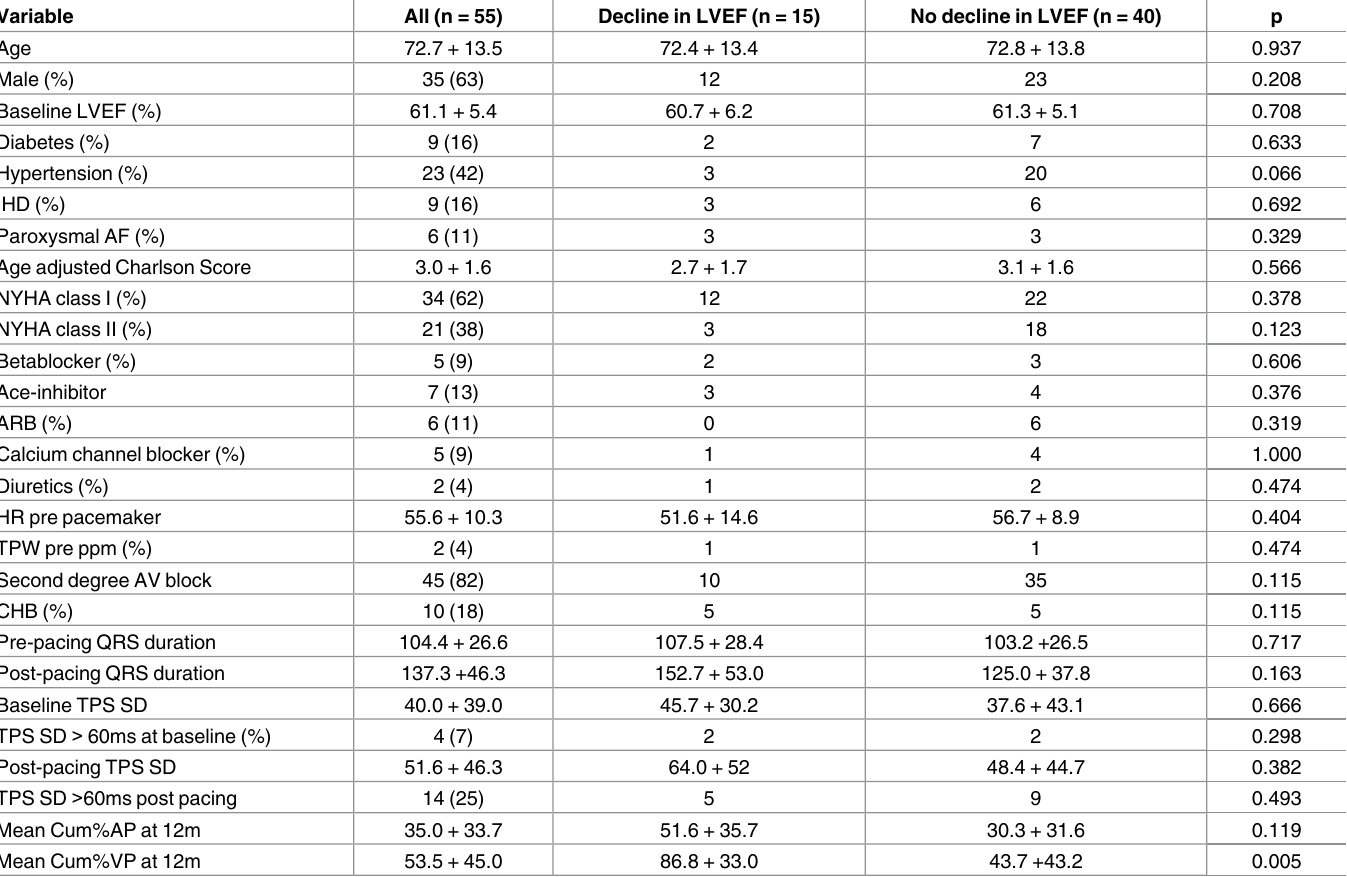
Table 1. Clinical characteristics between patients with low and high burdens of ventricular